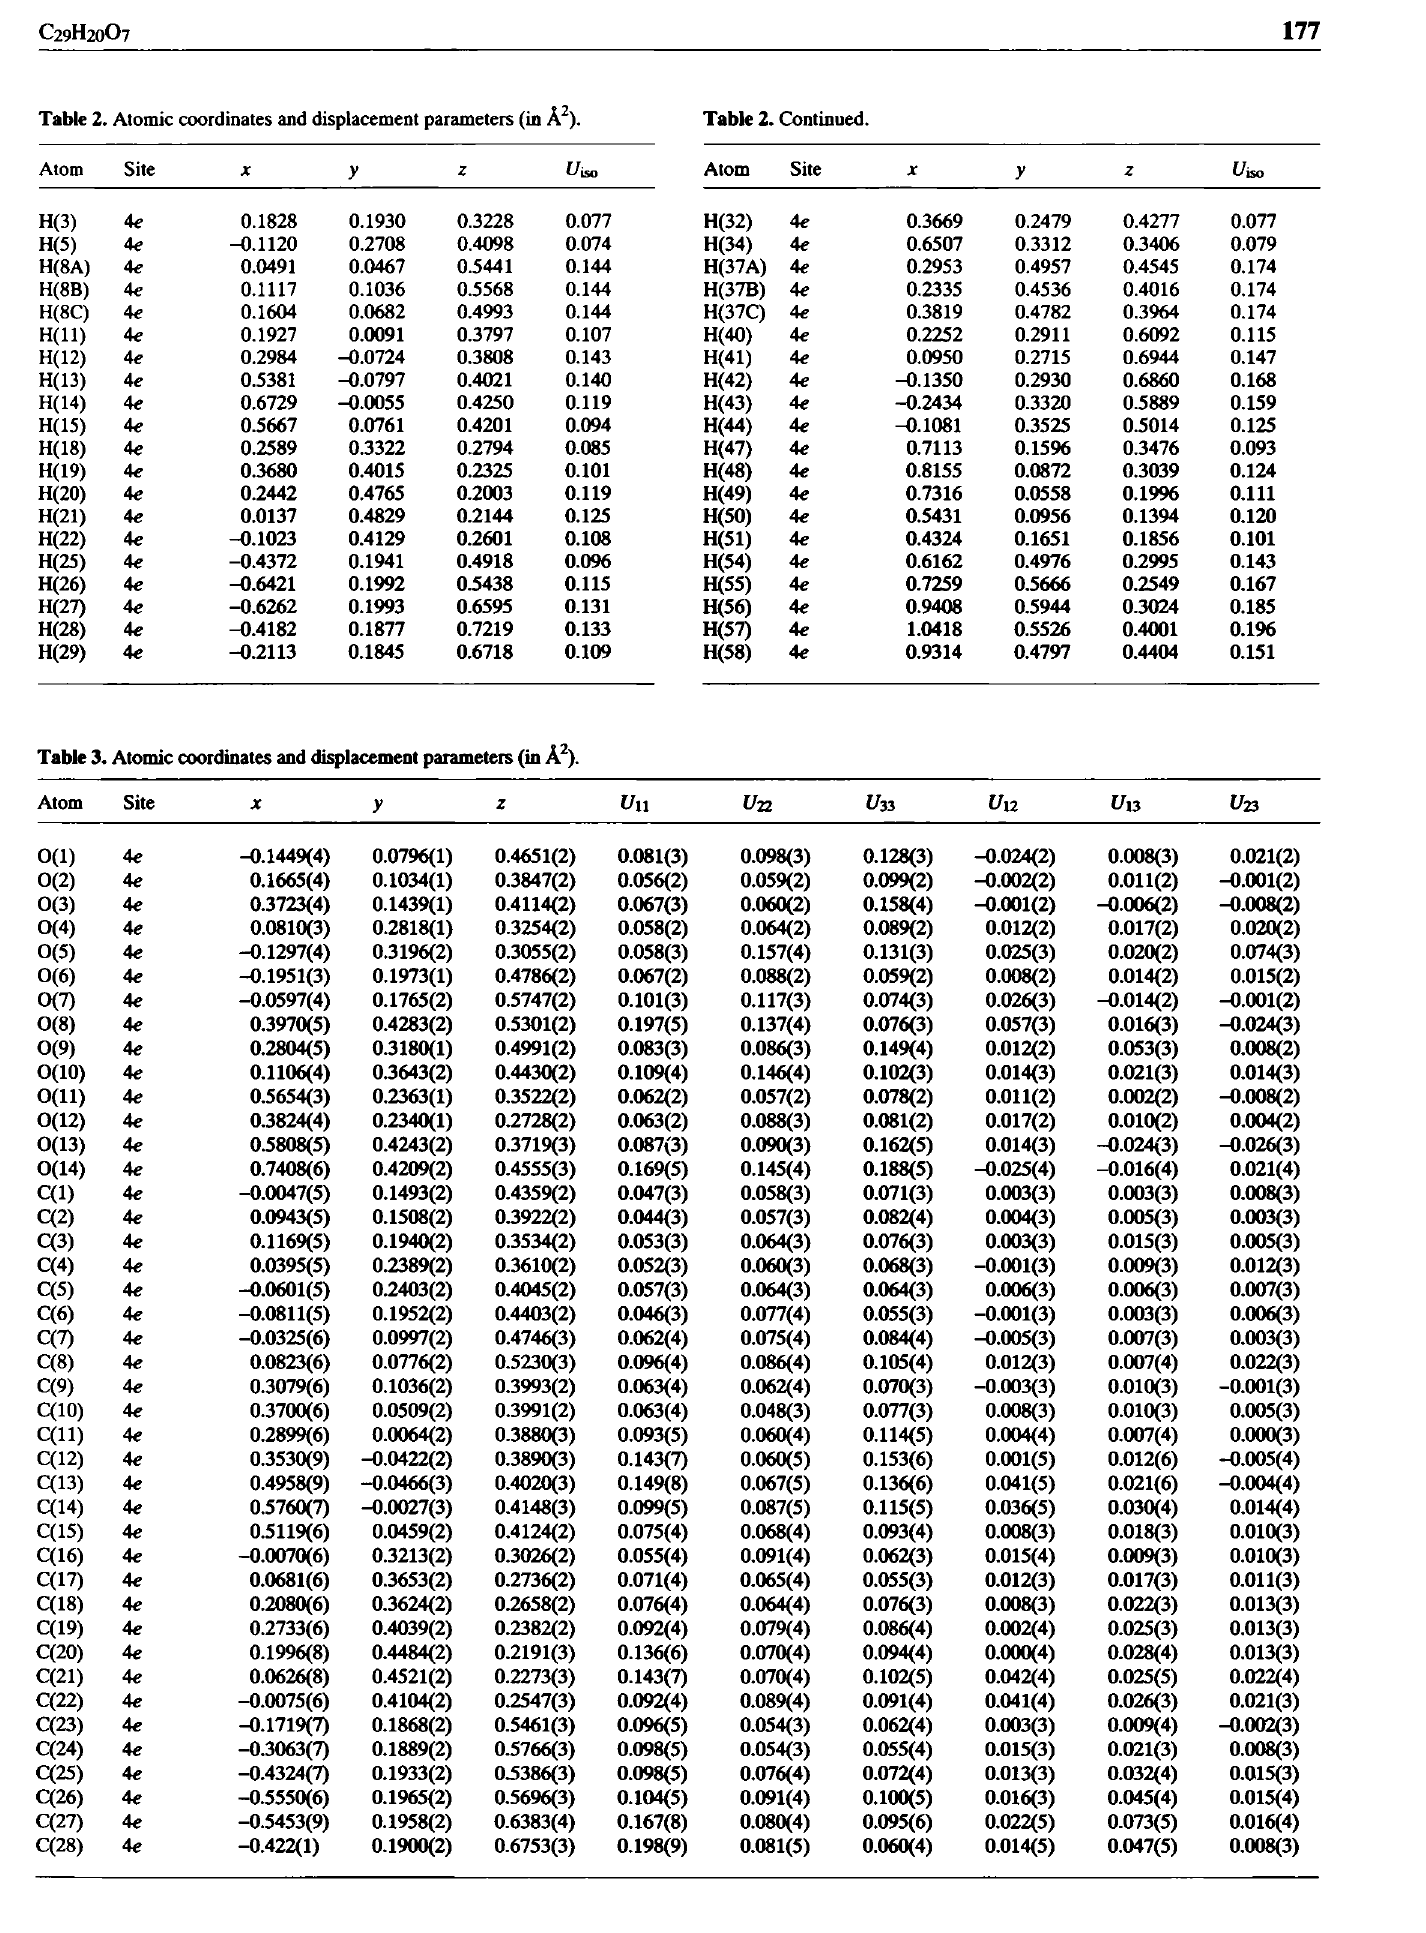
Table 2. Atomic coordinates and displacement parameters (in Ä 2 ).